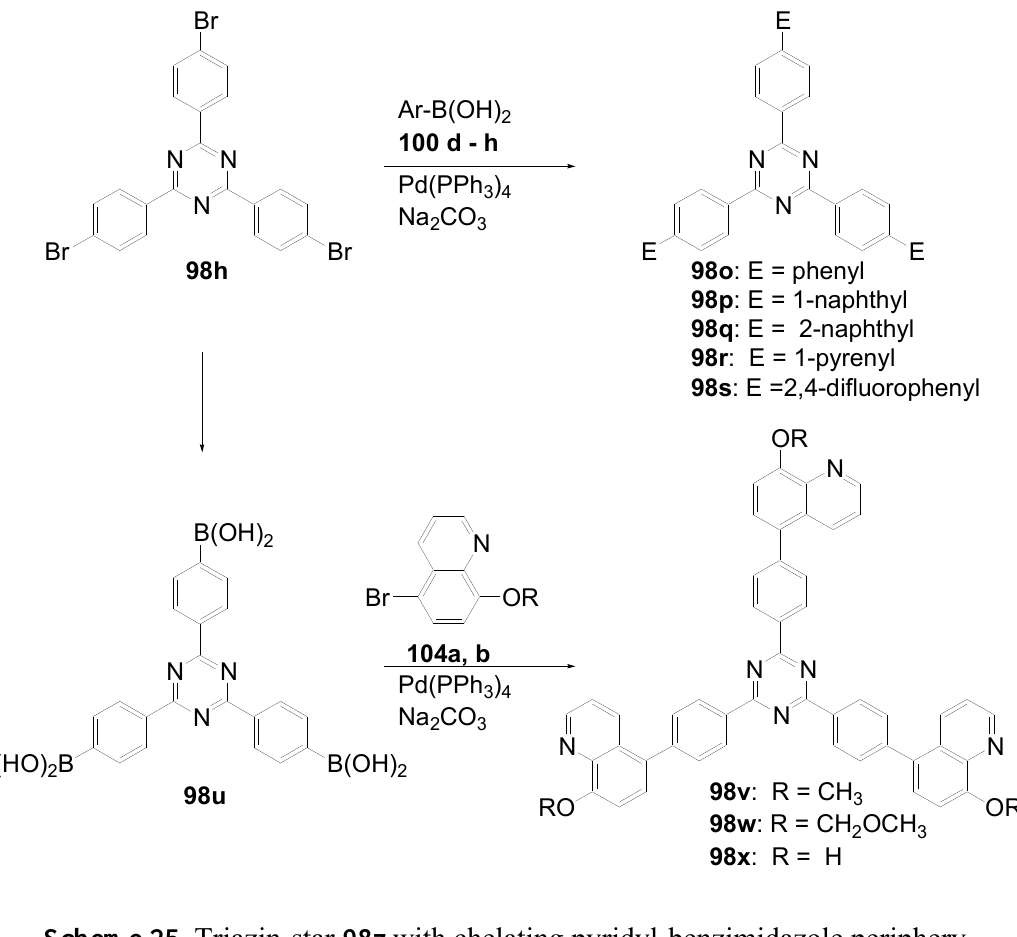
Scheme 24. Synthesis of tris(biaryl)triazine stars via Suzuki